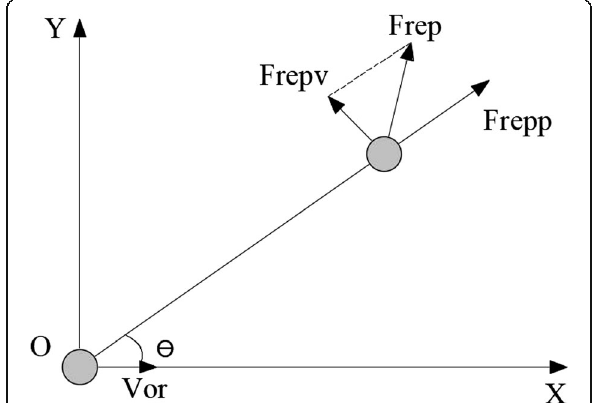
Fig. 4 Repulsive force diagram of robot